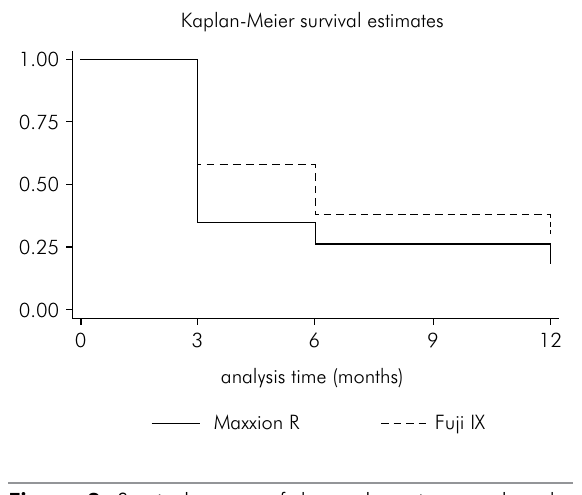
Figure 2. Survival curves of the sealants in regard to the materials used. Log-rank, p-value < 0.001.